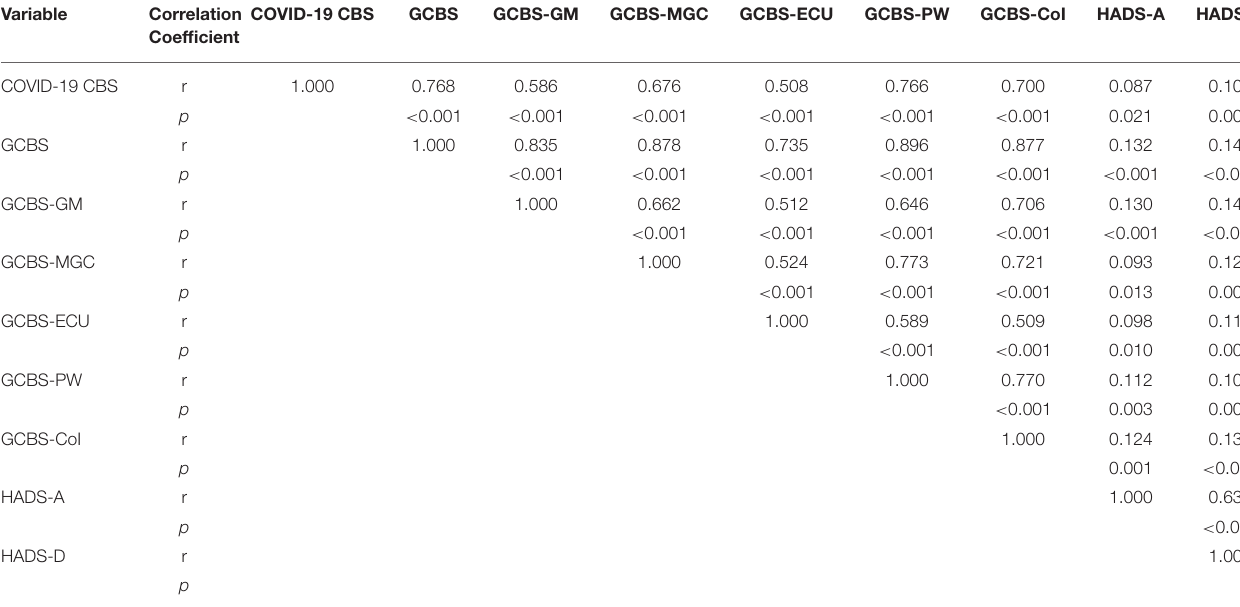
TABLE 3 | Correlations between COVID-19 CBS, GCBS and the severity of anxiety and depression symptoms in a group of Polish respondents ( N = 700). Variable